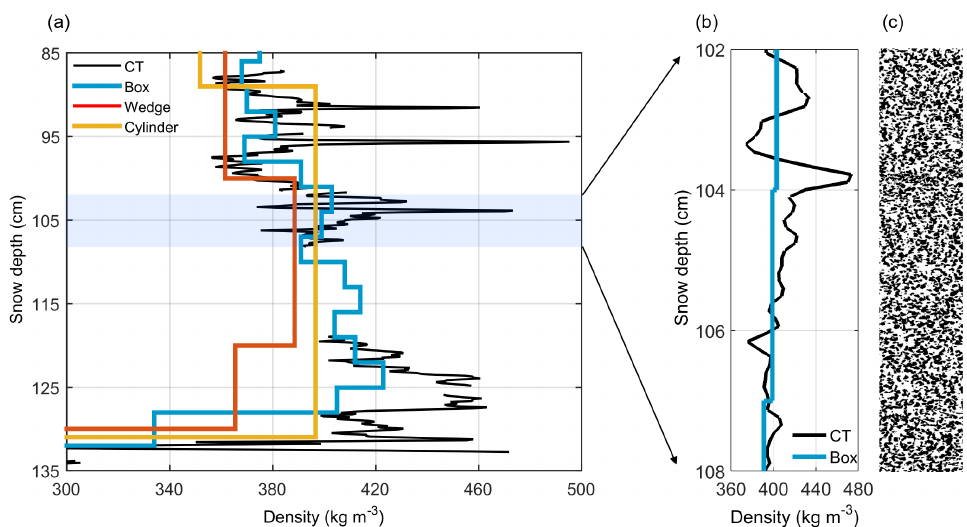
Figure 8. Close-up of the lower part of the density profile measured by the density cutters and µ CT (a) . The shaded area indicates the location of the µ CT sample no. 9. Density profile (b) and 2-D reconstruction (c) of µ CT sample no.